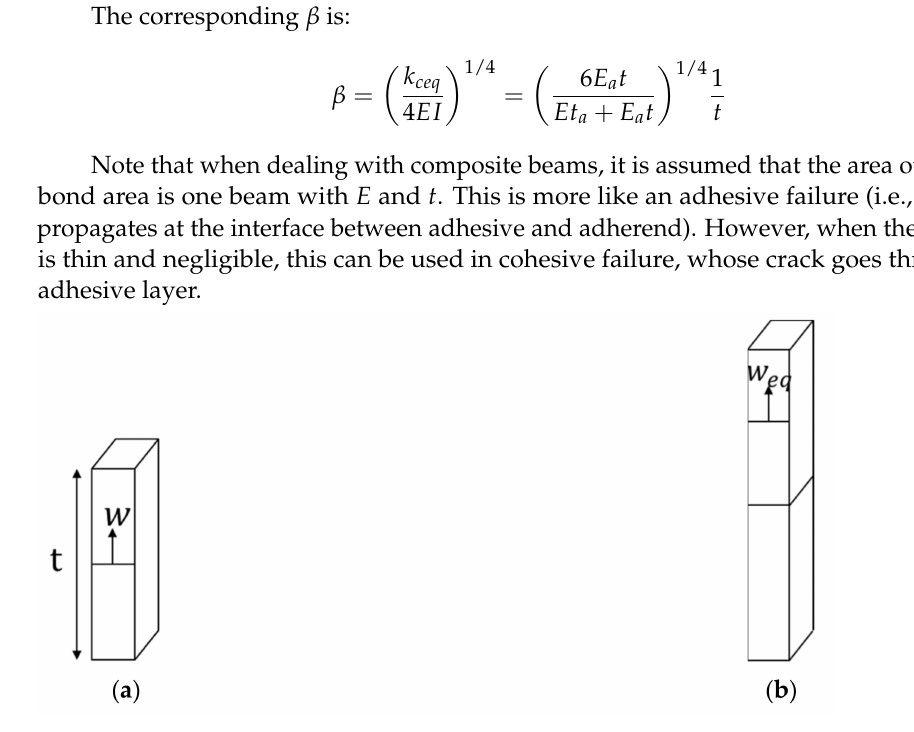
Figure A1. A diagram of determining the spring constant. ( a ) Isotropic beam. ( b ) Composite